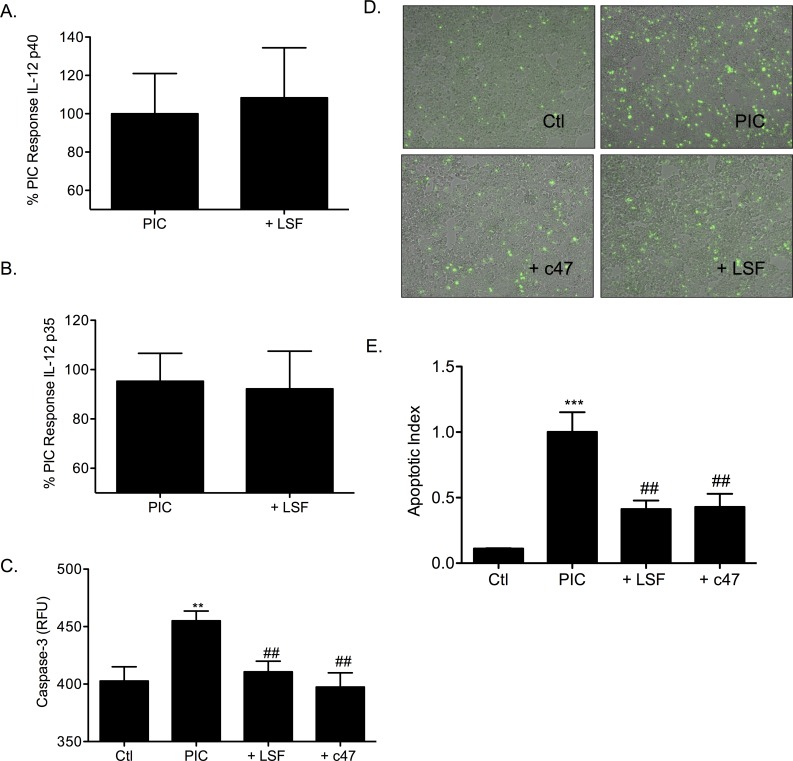
Lisofylline protects β-cells from PIC-induced apoptosis.(A) IL-12 p40 and (B) IL-12 p35 gene expression in PIC-treated βTC-3 cells without or with 20μM Lisofylline (LSF). (C) PIC-induced caspase-3 activation in the absence or presence of 20μM LSF or 50μM c47 in βTC-3 cells. Graph shows pro-caspase-3 cleavage relative fluorescent units (RFU). (D) Apoptosis was measured in PIC-treated βTC-3 cells without or with 20μM LSF or 50μM c47. Cells were examined microscopically following labeling with the viability dye, YO-PRO-1 (green). Representative images are shown for untreated (Ctl), PIC-treated, PIC with 50μM c47, or PIC with 20μM LSF respectively. (E) Graph shows quantified apoptotic index. ** p < 0.01, *** p < 0.001 relative to ctl, ## p < 0.01 relative to PIC and n ≥ 3.